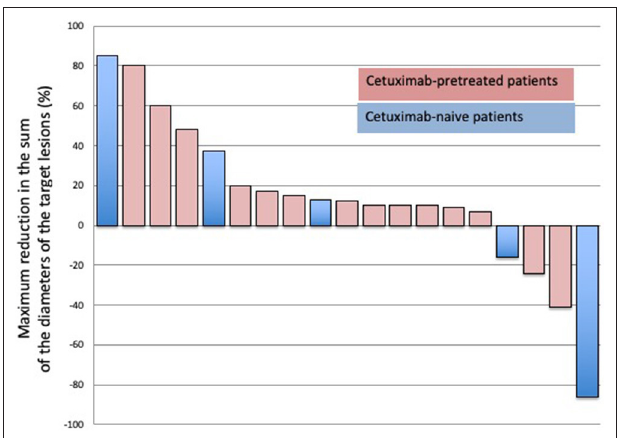
FIGURE 1 | Waterfall plots showing the maximum percentage modification in the sum of the diameters of the target lesions in assessable patients.